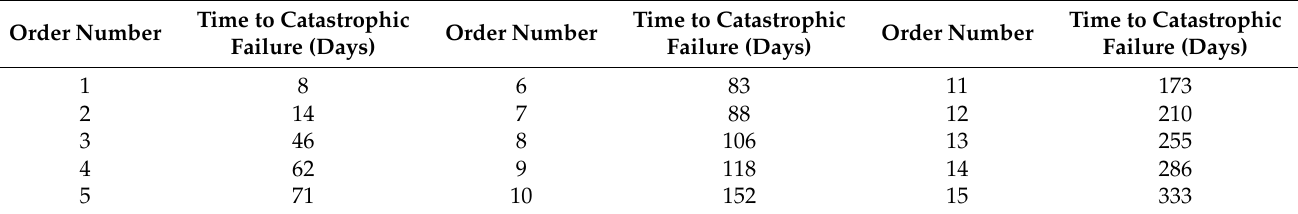
Table 4. The correlation coefficients of the five candidate distributions.